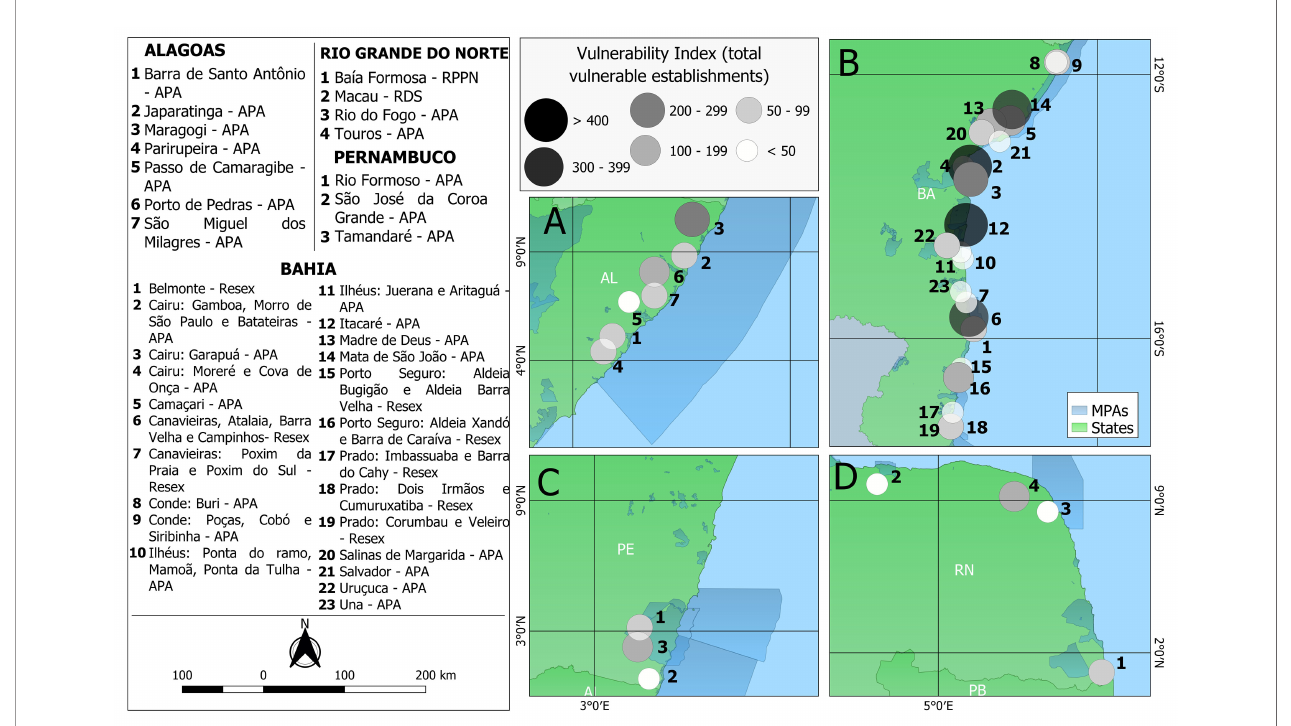
FIGURE 2 | Vulnerability Index (VI) in human communities living in or near the marine protected areas (highlighted by blue color) affected by oil spill (2019/2020), Northeast region of Brazil (Southwestern Atlantic). Human Communities in the states of (A) Alagoas (AL); (B) Bahia (BA); (C) Pernambuco (PE); (D) Rio Grande do Norte